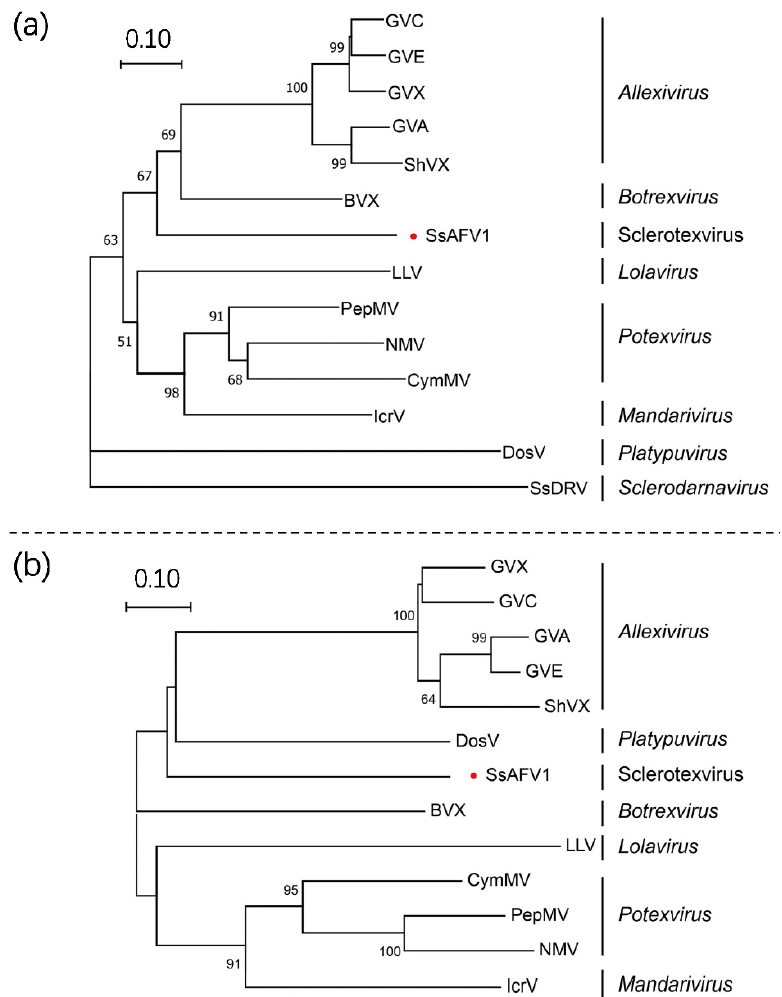
Figure 5. Phylogenetic analysis of SsAFV1 and representative members of the family Alphaflexiviridae based on the alignment of replicase ( a ) and CP ( b ). These ML trees were constructed as described with calculated best-fit model LG + I + G4 for replicase and LG + G4 for CP. The parameter of bootstrap was set as 1000 replicates and bootstrap values over 50% were indicated on branches. The virus studied in this paper was tagged with a red dot; the scale bar at the top left corresponds to the genetic distance. Details of these alphaflexiviruses are given in Table S1.